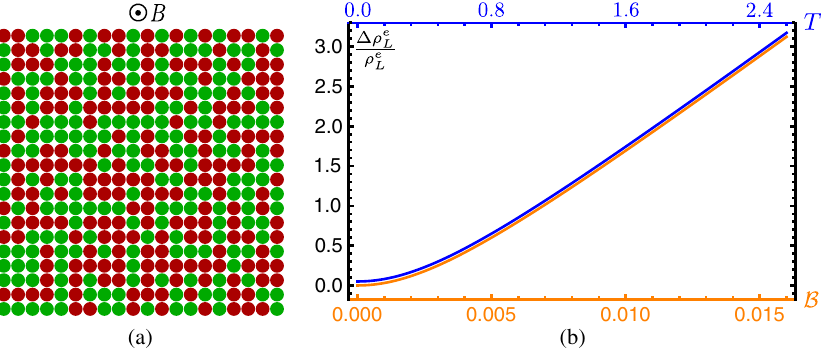
FIG. 4. (a) A two-dimensional sample with a random distribution of approximately equal fractions of two types of domains, for which an exact analytic solution of the effective-medium equations for magnetotransport is possible. The magnetic field B points out of the plane of the sample. (b) Plots of the normalized change in global longitudinal resistance due to dimensionless magnetic field B (orange) and due to temperature T (blue), obtained from Eq. (5.9). We use E F the flux per unit cell Ba 2 in units of ℏ =e [Eq. (4.8)]. We use m ¼ 0 . 005 ∼ 1 =E F γ ¼ 0 . 1 , and the blue ( T ) curve is evaluated at B ¼ 0 . 0025 and γ a lie on top of each other, demonstrating a scaling between magnetic field and temperature. Both the B and T dependencies are quadratic at small fields or temperatures and cross over to linear at large fields or